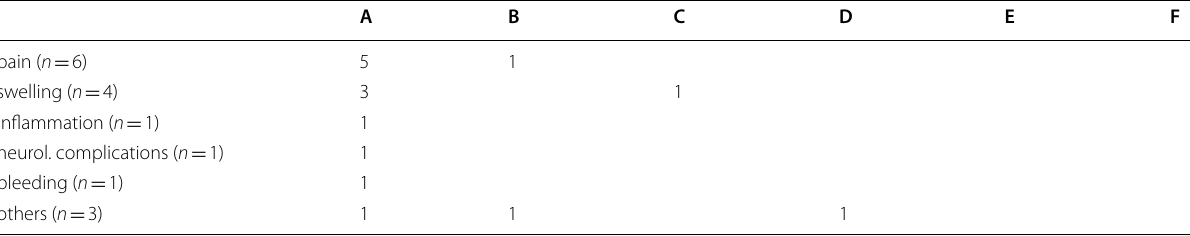
Table 11 Severity of certain complications (Society for Interventional Radiology